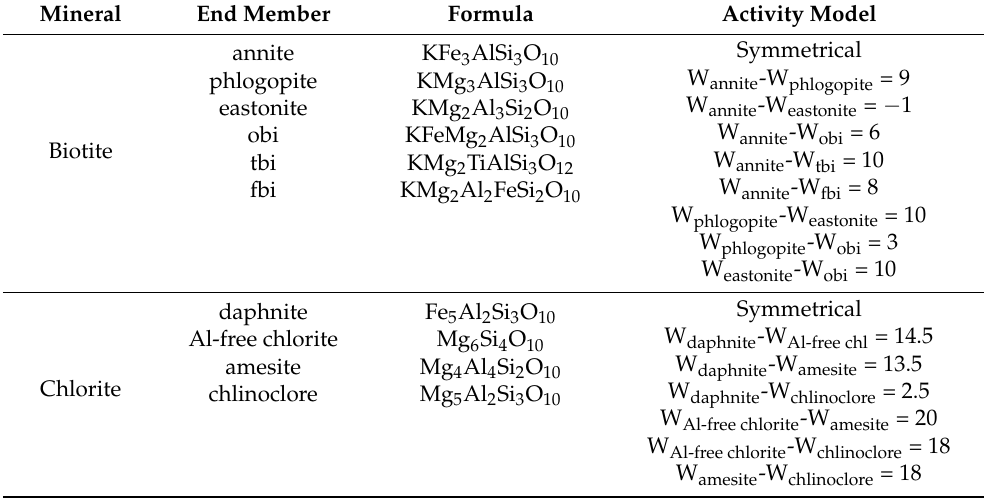
Table A6. Solid solutions used in the modeling of type and “oxidized” pelite. The thermodynamic properties of end members are from Holland and Powell [19] and White et al.